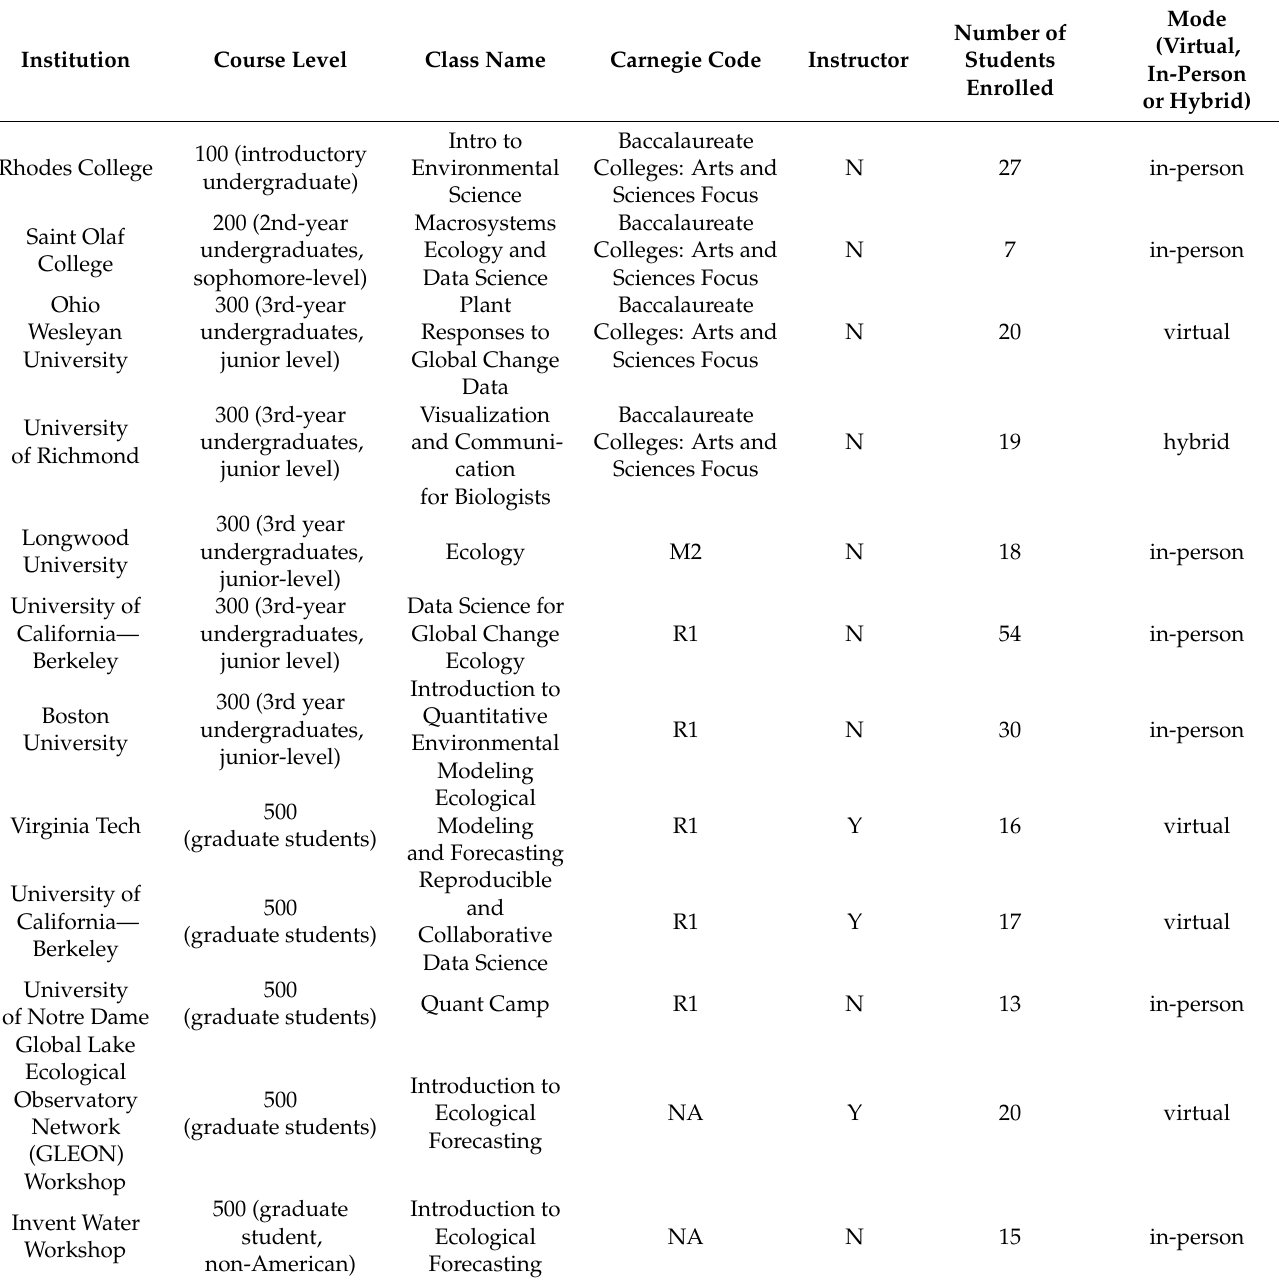
Table 2. Summary of institutions and classes which taught Macrosystems EDDIE Module 5 In- troduction to Ecological Forecasting as part of our assessment. Carnegie Codes are defined as R1: Doctoral Universities—Very high research activity, M2: Master’s Colleges and Universities— Medium programs; when not available, descriptions from the Carnegie classifications website (https://carnegieclassifications.acenet.edu/; accessed on 25 April 2022) are provided instead. If one of the co-authors on this paper was an instructor for the class, it is indicated with a Y in the Instructor column and a N if